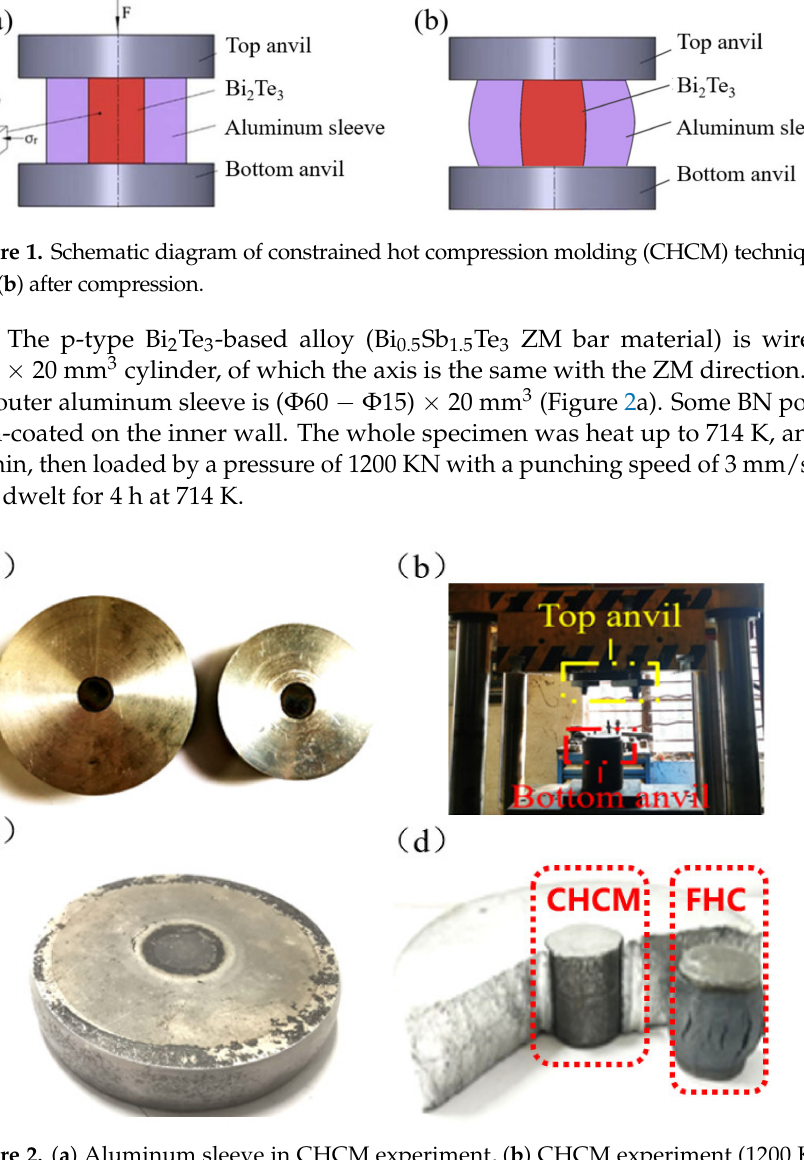
Figure 2. ( a ) Aluminum sleeve in CHCM experiment, ( b ) CHCM experiment (1200 KN press), ( c ) photo of mold after CHCM test, ( d ) comparison of the appearance between CHCM and FHC